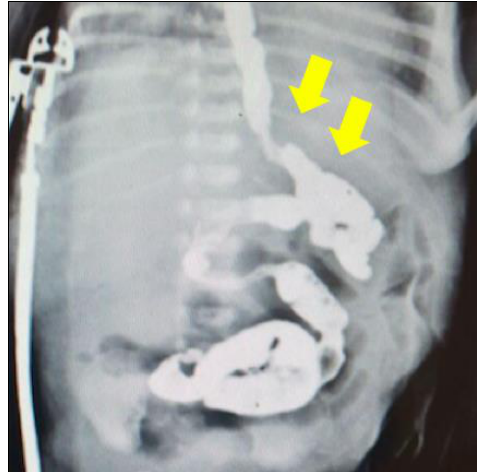
Figure 2: No leakage